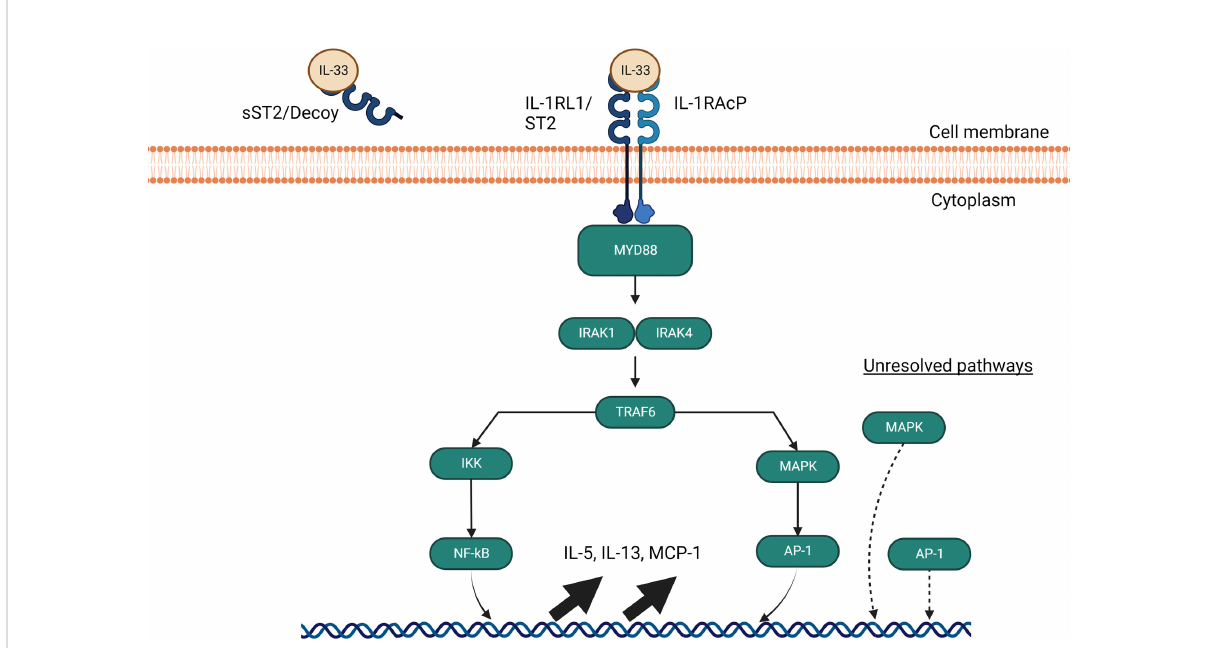
FIGURE 4 IL-33 signalling pathways through MyD88. The IL-33 signaling pathway requires a heterodimer of ST2 and IL-1 receptor accessory protein (IL- 1RAcP) to activate and signal through MyD88. If IL-33 avoids binding to soluble ST2 decoys, it signals through MyD88 to interact with IRAK1 and IRAK4, which in turns activate TRAF6 and leads to NF-kB and AP-1 gene upregulation of IL-5, IL-13 and MCP-1. AP-1 is also able to activate independently of MyD88 through an undiscovered pathway involving MAP